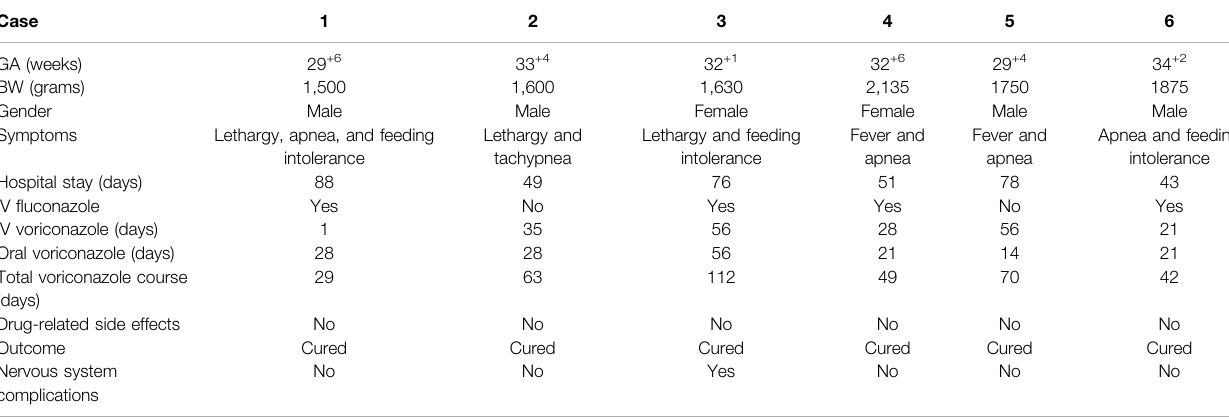
TABLE 1 | General information of the 6 cases of fungal meningitis.